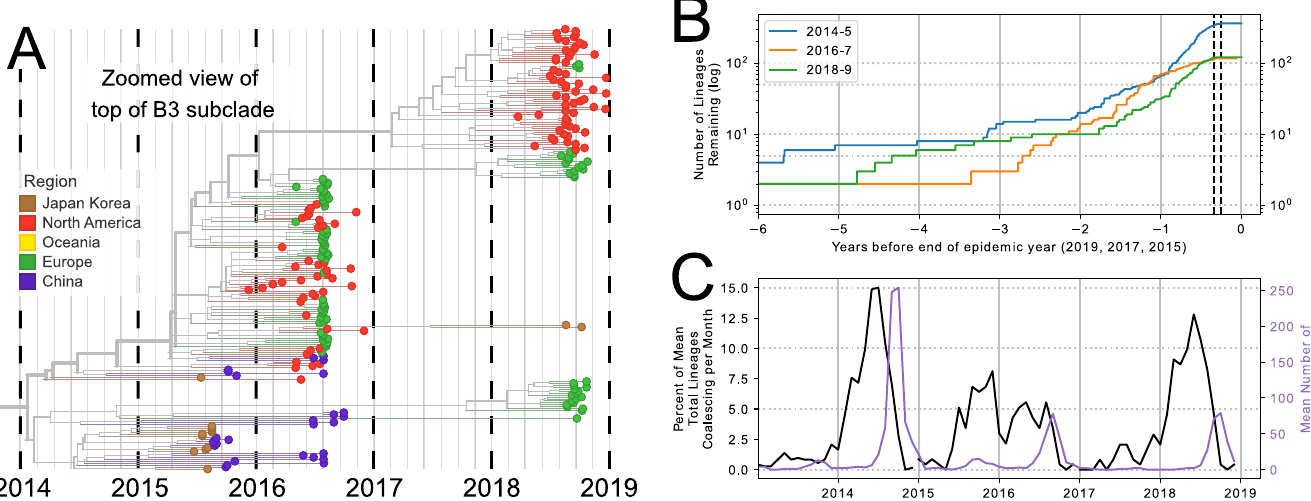
Fig 2. Persistence and diversification of EV-D68 since 2014. Multiple EV-D68 lineages persist from one biennial outbreak to another. (A) Zoomed-in view of the whole genome EV-D68 tree (for better time-resolution), showing 2018 subgroups in the B3 subclade. (B) Lineages which are ancestral to all of the samples in the 2014, 2016, and 2018 seasons diversify over time. The dotted black lines show the IQR of all samples taken during 2014, 2016, and 2018. (C) The change in number of lineages (as % of total lineages) per month for each season (left y-axis) and the mean number of samples per month (right y-axis).